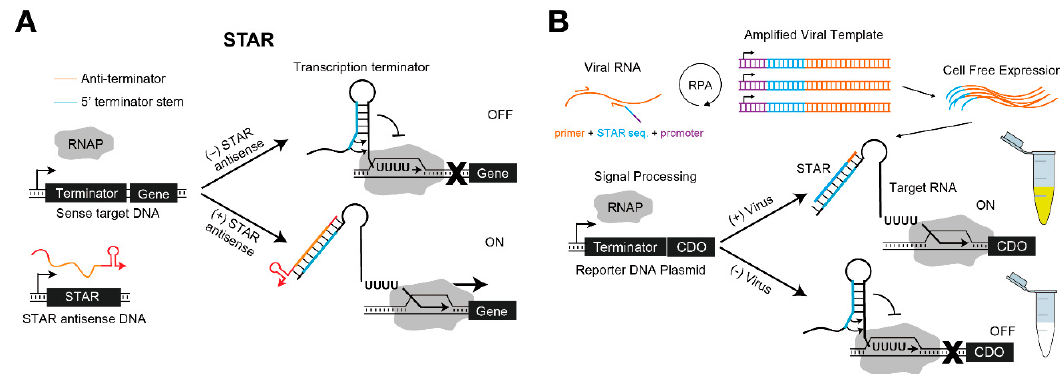
Figure 6. Small transcription activating RNA (STAR) system and application for detecting plant pathogens. ( A ) Mechanism of STAR. A transcription terminator consists of a stem-loop and a poly-U track, where the binding of STAR RNA breaks the step-loop structure such that transcription proceeds normally. ( B ) A platform to diagnose plant pathogens using STAR. Viral RNA in the sample can be amplified with the addition of a STAR sequence and a promoter through recombinase polymerase amplification (RPA). Then, the corresponding RNA transcribed through cell-free expression induces the expression of reporter gene (CDO, catechol 2,3-dioxygenase). RNAP: T7 RNA polymerase.